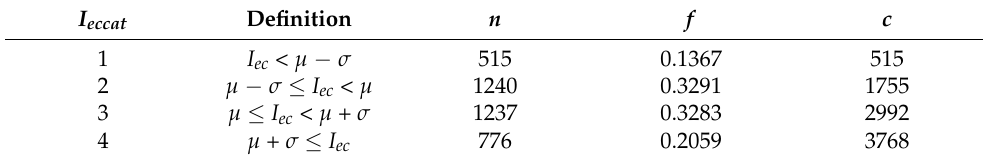
Table 1. Categorization of coherent index of economic situation ( I ec ) and numbers in population. I